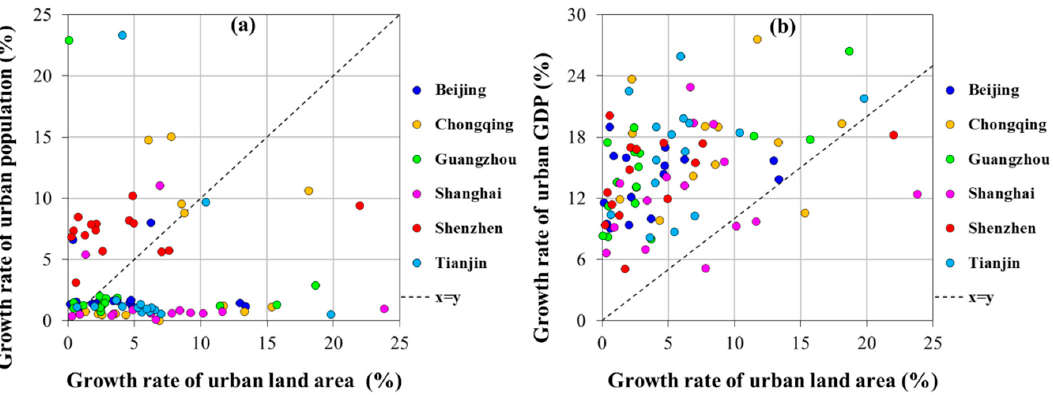
Figure 8. Relationships ( a ) between growth rate of urban land area and population, and ( b ) between growth rate of urban land area and GDP.